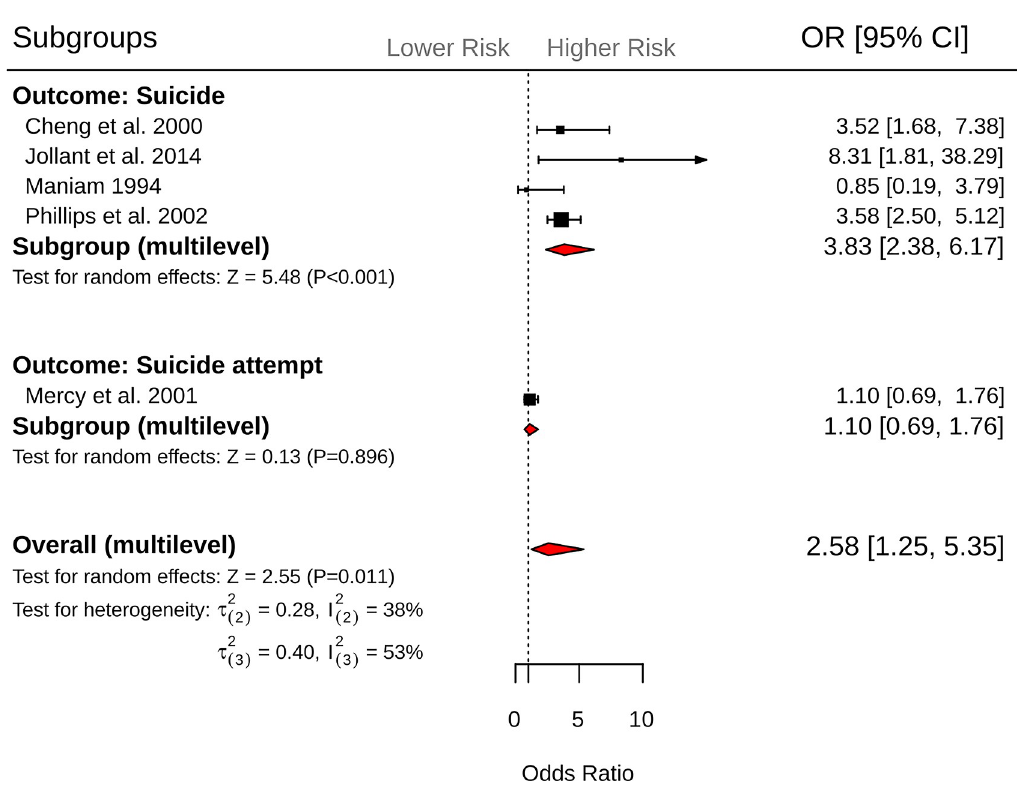
Fig 4. Forest plots of exposure to suicidal behavior (composite measure—suicide or suicide attempt) and subsequent suicide and suicide attempt outcomes. CI, confidence interval; OR, odds ratio.